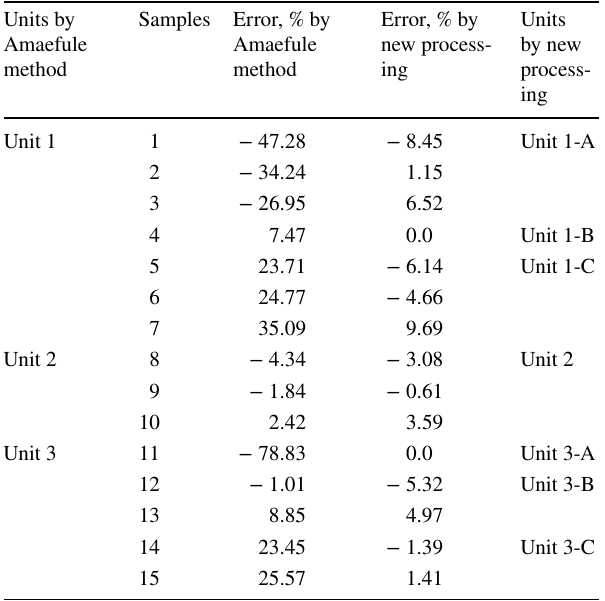
Table 2 Errors of predicted permeability using different methods Samples Error, % by Units by Amaefule method